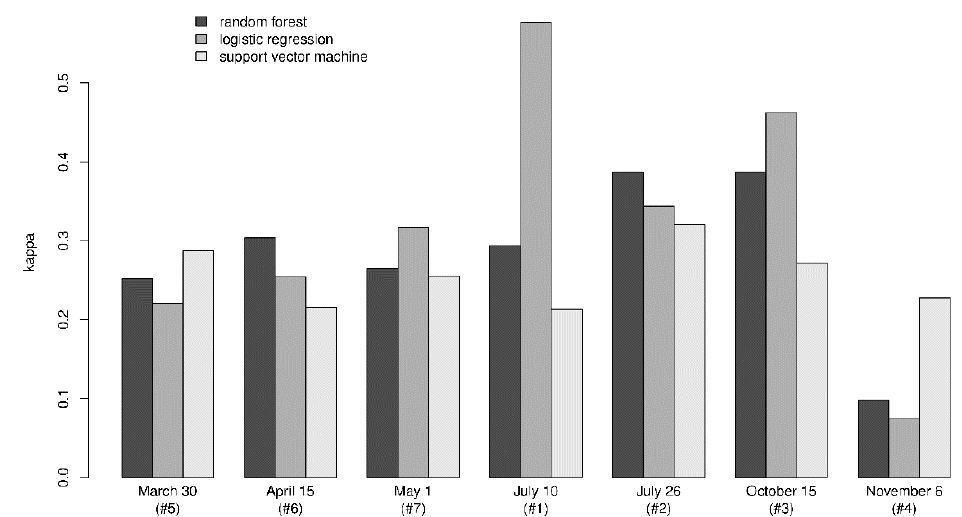
Figure 3. Classification accuracy for models using only data from each of the individual Landsat images.